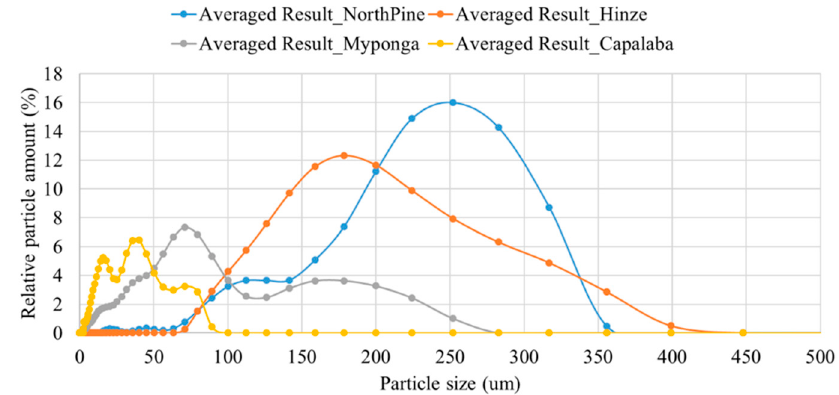
Figure 4. Particle size distribution (PSD) results for the four water samples.